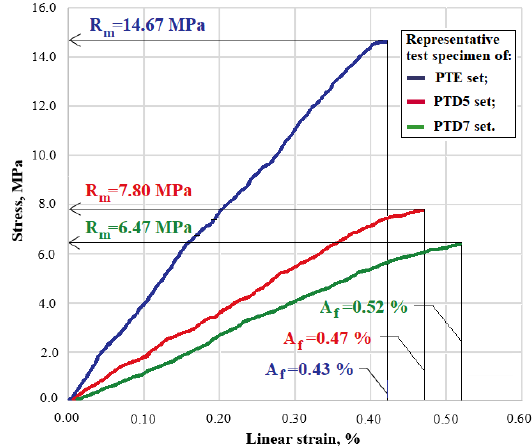
Figure 5. Strength–strain diagram for representative specimens from PTE, PTD5 and PTD7